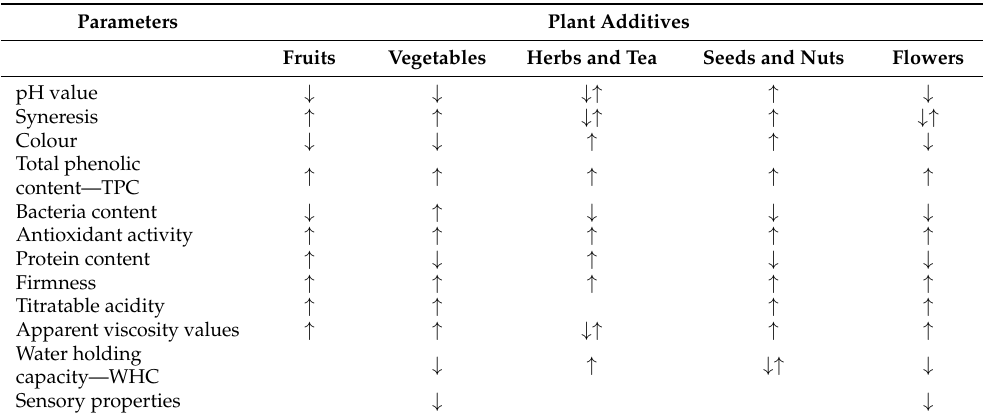
Table 4. Summary of the effect of plant additives on the physicochemical, microbiological and sensory characteristics of yoghurts (own elaboration).